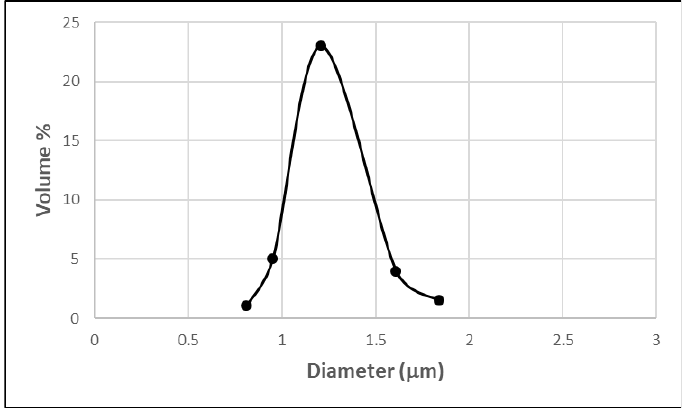
Figure 4. Size distribution of oil/water (o/w) emulsion produced by membrane emulsification. D[3,2] and D[4,3] of 1.49 (±0.3) µm and 1.52 (±0.3) µm were obtained, respectively